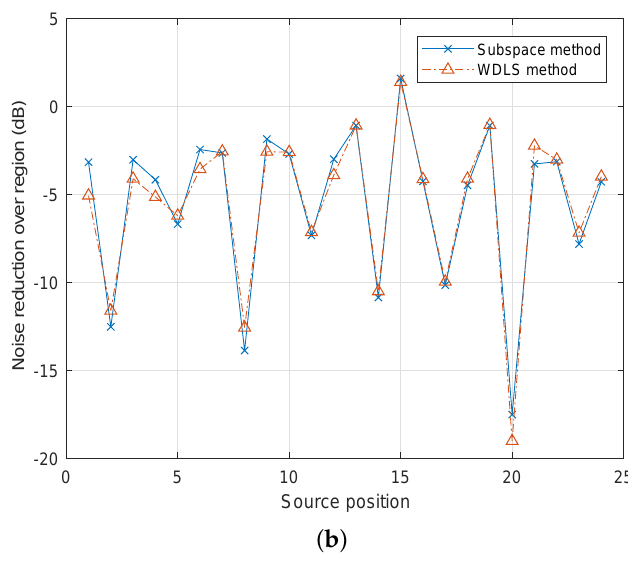
Figure 6. Noise reduction performance in case 3, when the noise field is generated by one primary source moving around the sphere using different methods: ( a ) with SNR = 60 dB white noise on the microphone recordings; ( b ) with SNR = 30 dB white noise on the microphone recordings.